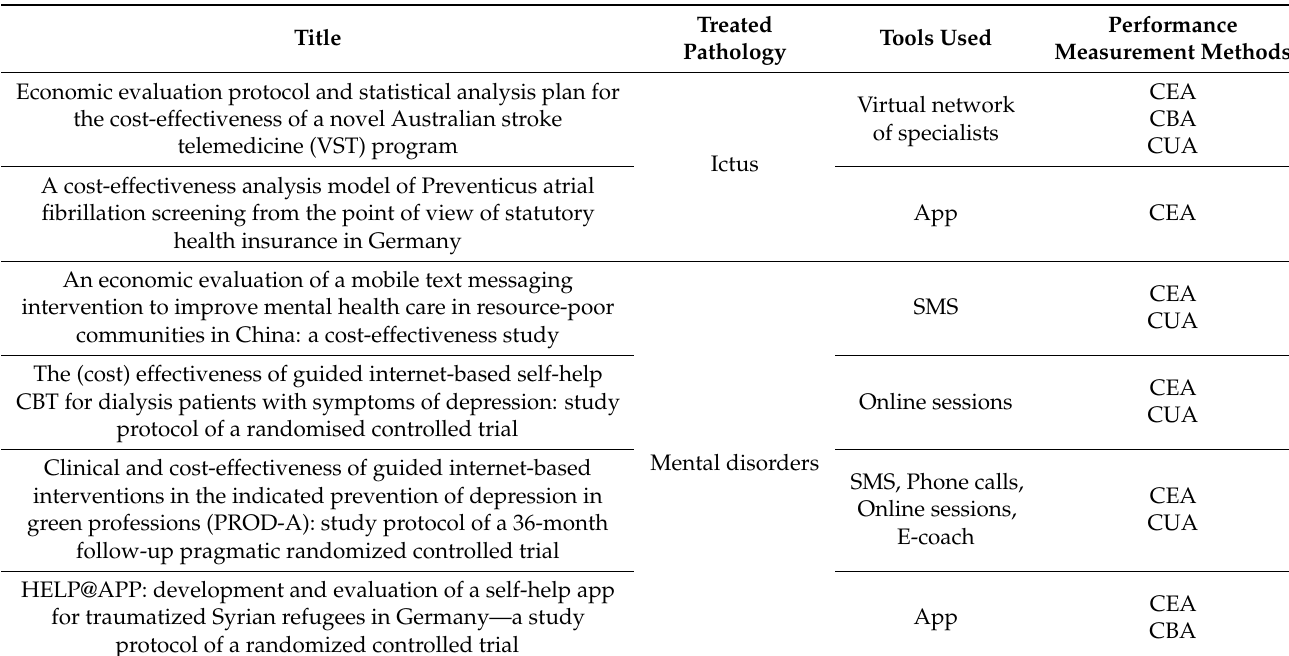
Treated Performance Tools Used Pathology Measurement